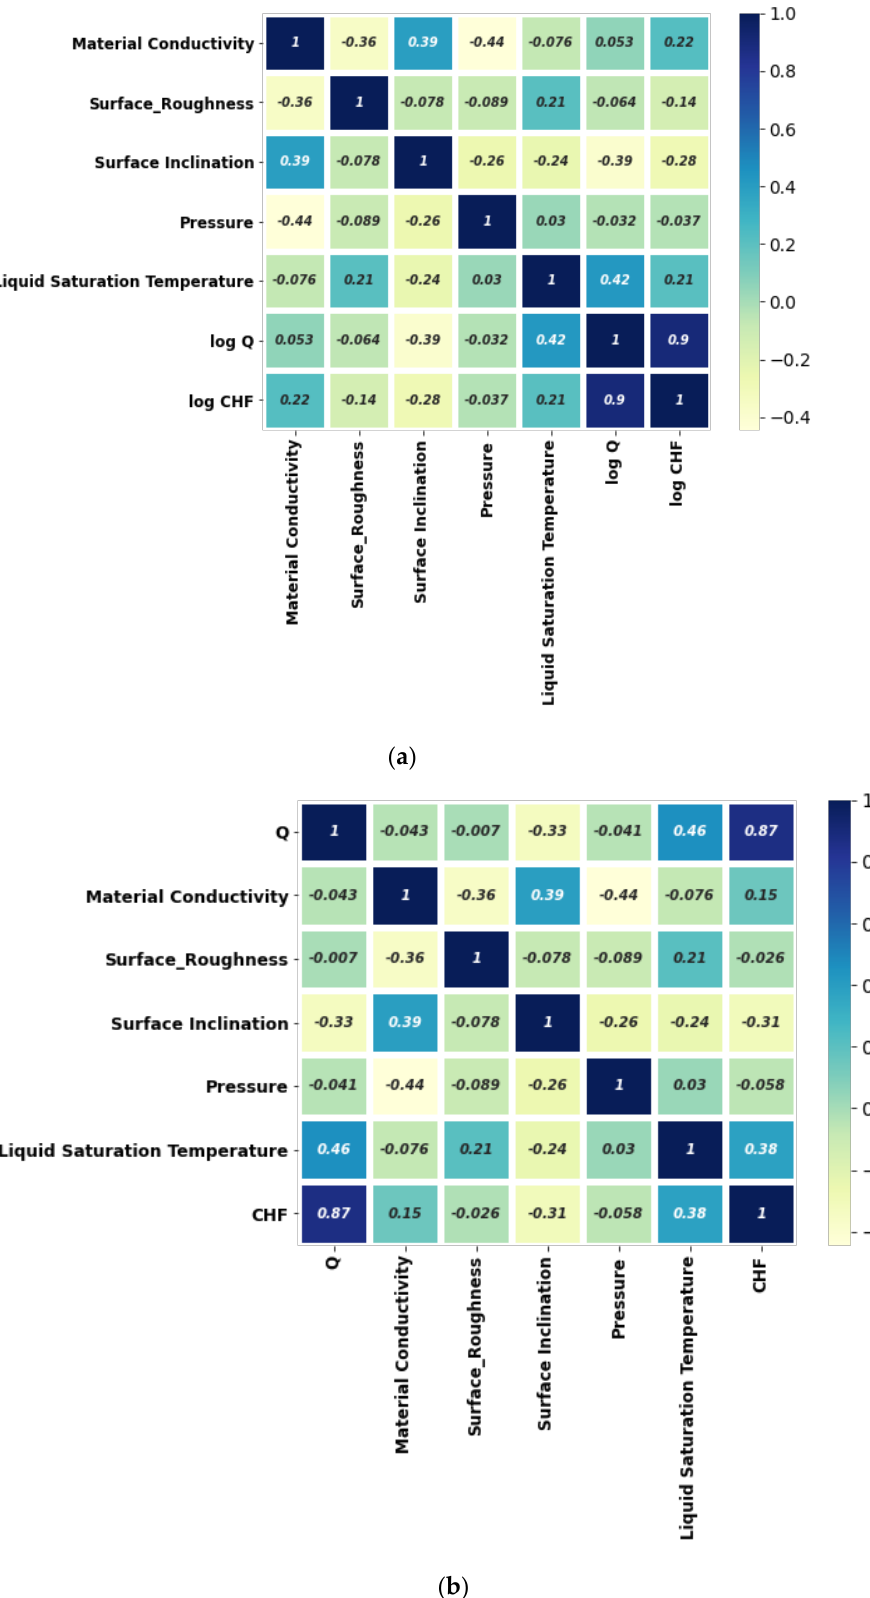
Figure 8. Normal heat map for CHF data correlation ( a ) without feature engineering and ( b ) with